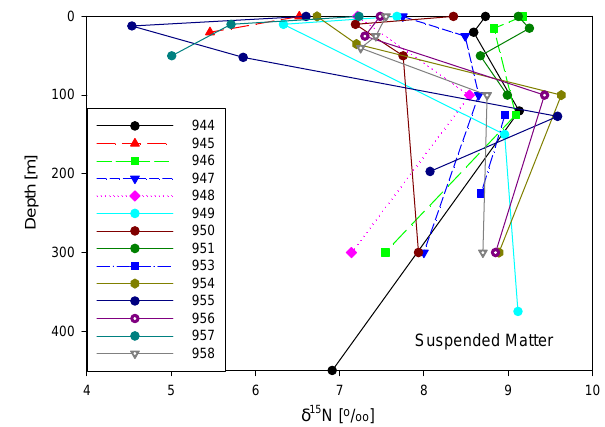
Fig. 3. Vertical profiles of δ 15 N PN in large volume filtration samples from conventional water samplers and in situ